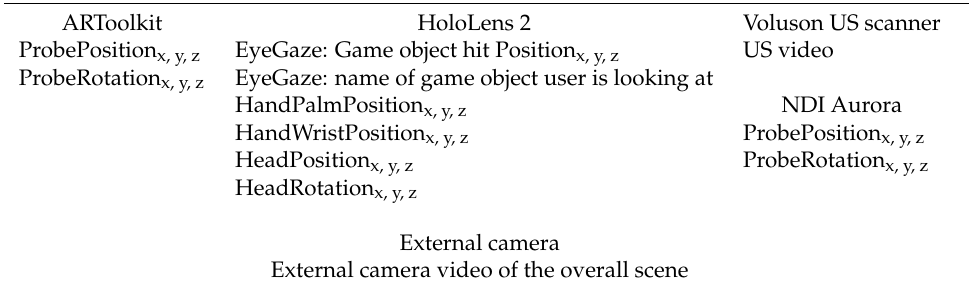
Table 1. Data recorded by the CAL-Tutor